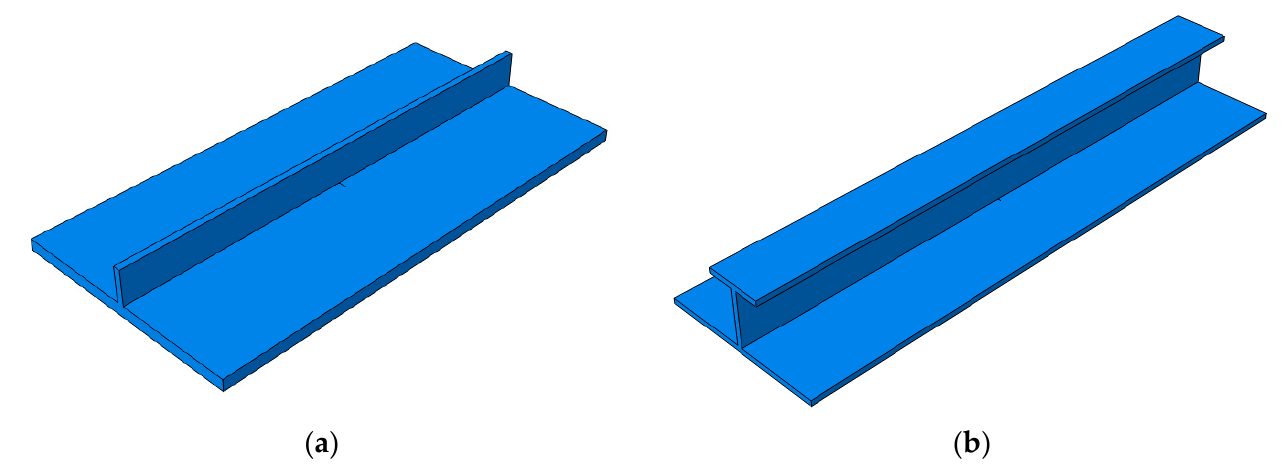
Figure 9. Geometries of stiffened panels: ( a ) tensile model; ( b ) bending model.